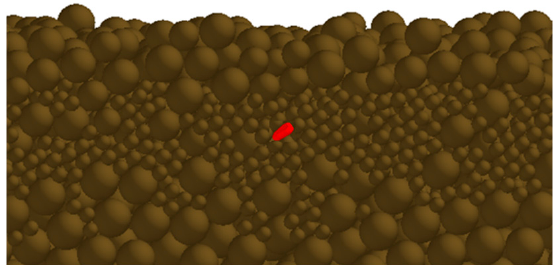
Figure 10. Effect drawing of covering soil. Red grains represent corn seed.